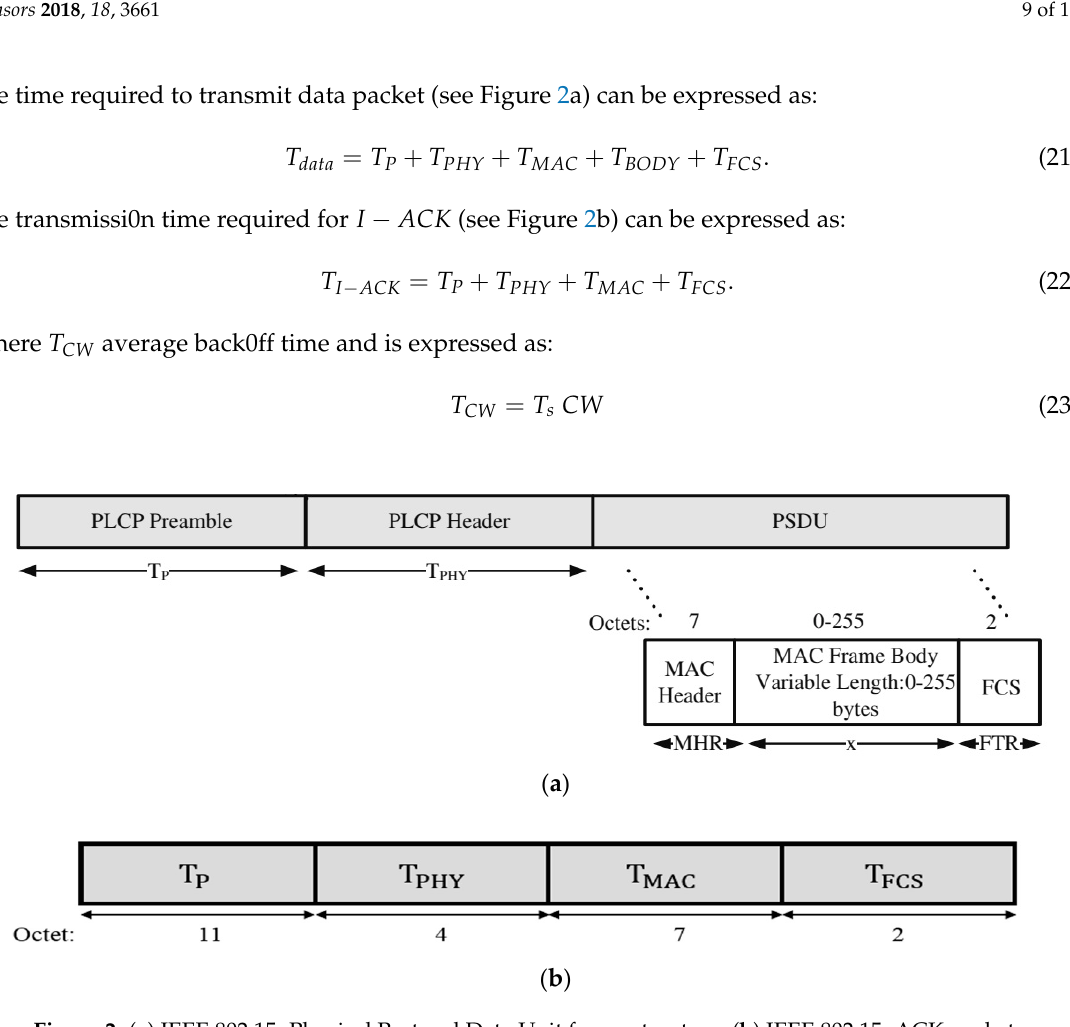
Figure 2. ( a ) IEEE 802.15. Physical Protocol Data Unit frame structure; ( b ) IEEE 802.15. ACK packet.